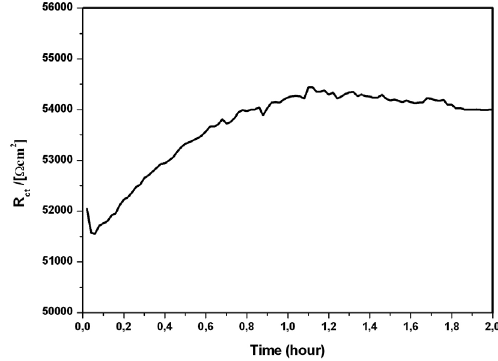
Figure 7. Charge transfer resistance evaluation vs. time of exposure in 1500 ppm mad honey in 3.5% NaCl solution, based on the DEIS results.